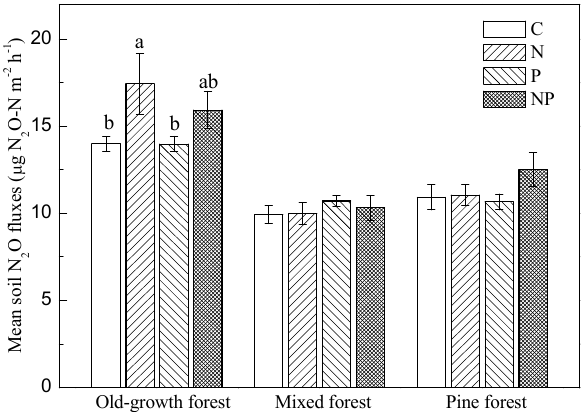
Figure 4. Effects of N and P addition on mean soil N 2 O fluxes from February 2007 to October 2009. Each error bar represents standard error of mean N 2 O fluxes from five plots ( n = 5), and the data of N 2 O fluxes in each plot have been averaged from the whole sam- pling period (33 months). Different lowercase letters within each forest represent significant differences among treatments, as deter- mined by repeated-measures ANOVA ( P <0.05).